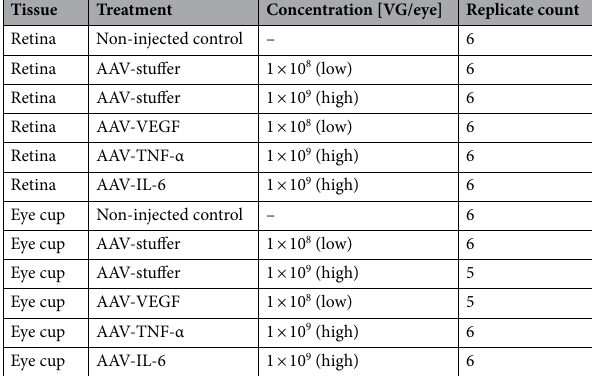
Table 1. Summary of all samples sequenced in the AAV study.